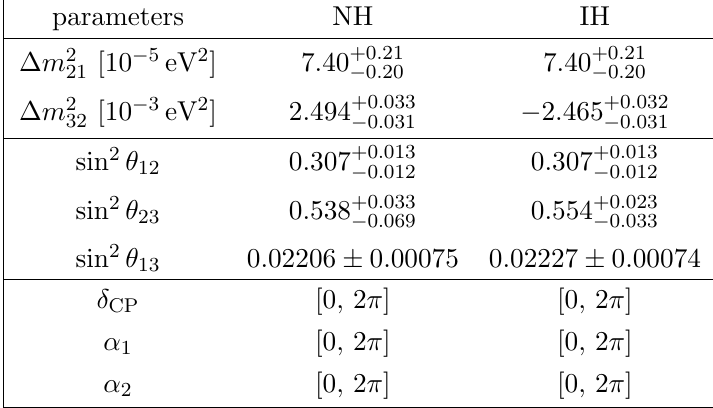
Table 1 . Best-(cid:12)t values and 1 (cid:27) ranges of the neutrino mass squared di(cid:11)erence and mixing pa- rameters for both NH and IH of neutrino spectra from a recent global (cid:12)t [79, 80]. The Dirac CP violating phase (cid:14) CP and the Majorana phases (cid:11) 1 ; 2 are considered to be unconstrained. global (cid:12)t results [79, 80] on the mass squared di(cid:11)erences and mixing angles are collected in table 1, including the central values and 1 (cid:27) uncertainties for both the normal hierar- chy (NH) and inverted hierarchy (IH) spectra of neutrino masses. We vary the CP phases within the whole range of [0 ; 2 (cid:25) ] (unless otherwise speci(cid:12)ed). Note that the recent T2K [81] and NO (cid:23) A [82] results indicate a mild preference for non-zero (cid:14) , but this has not been CP established at 5 (cid:27) level